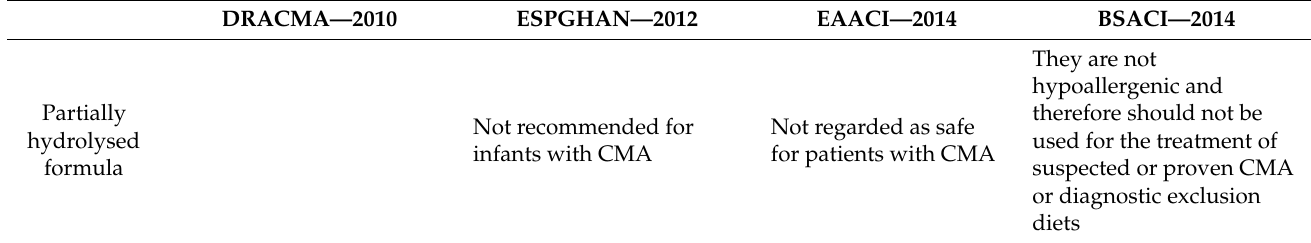
Table 3. Recommendations from current